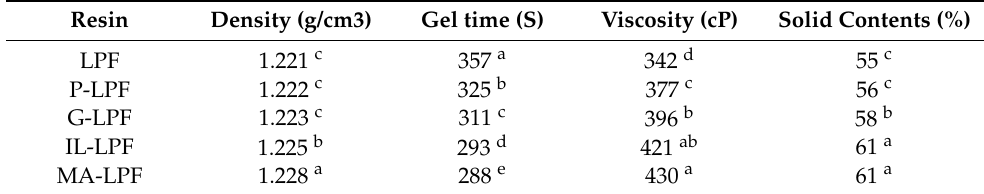
Table 1. Physicochemical properties of LPF